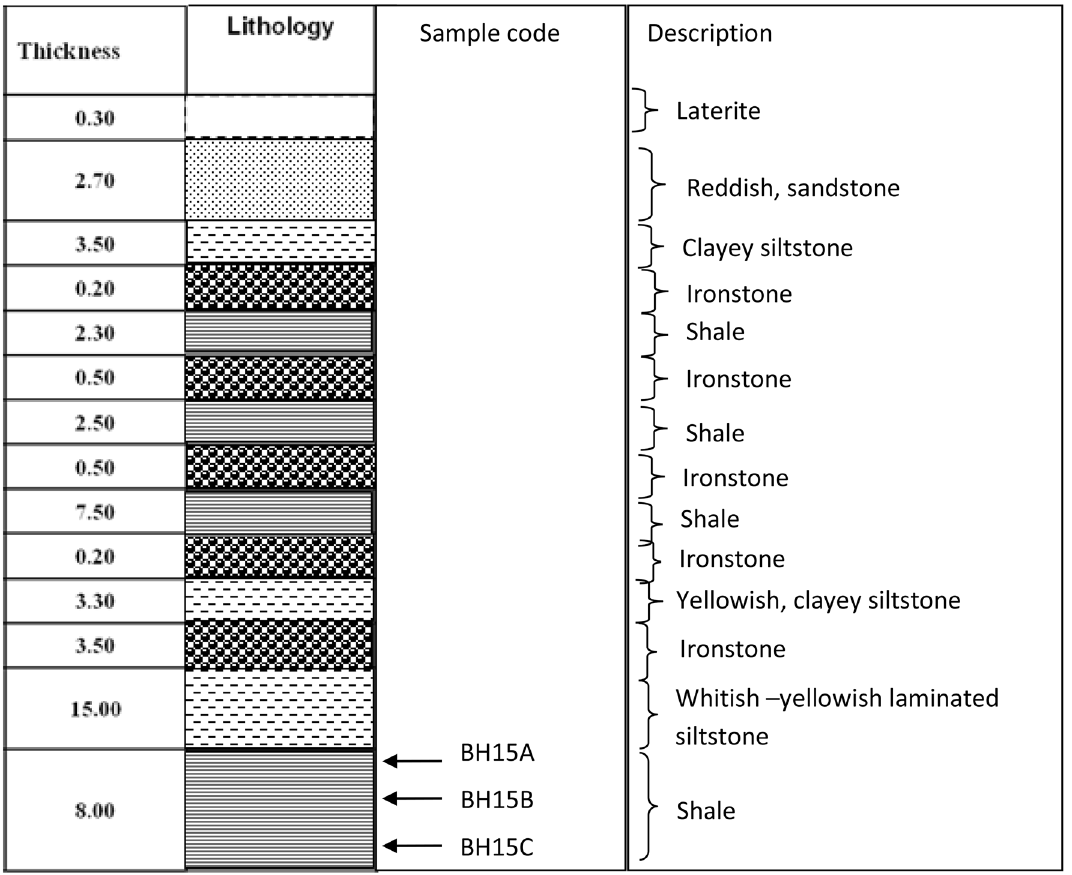
Fig. 6 Litholog of borehole sampled at Maiganga. GPS: x = 734,251, y = 1,105,749, z = 458. The log shows shale, siltstone and ironstone interca- lation. Arrow indicates selected